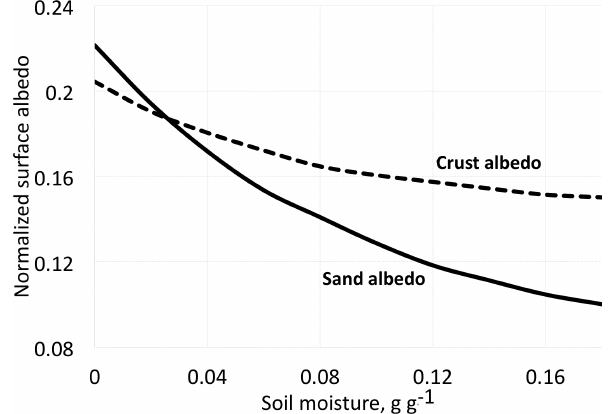
Figure 2. Albedo for desert dune sand with and without biological soil crust organisms (BSC) at different moisture contents. Redrawn and simplified from Zang et al.